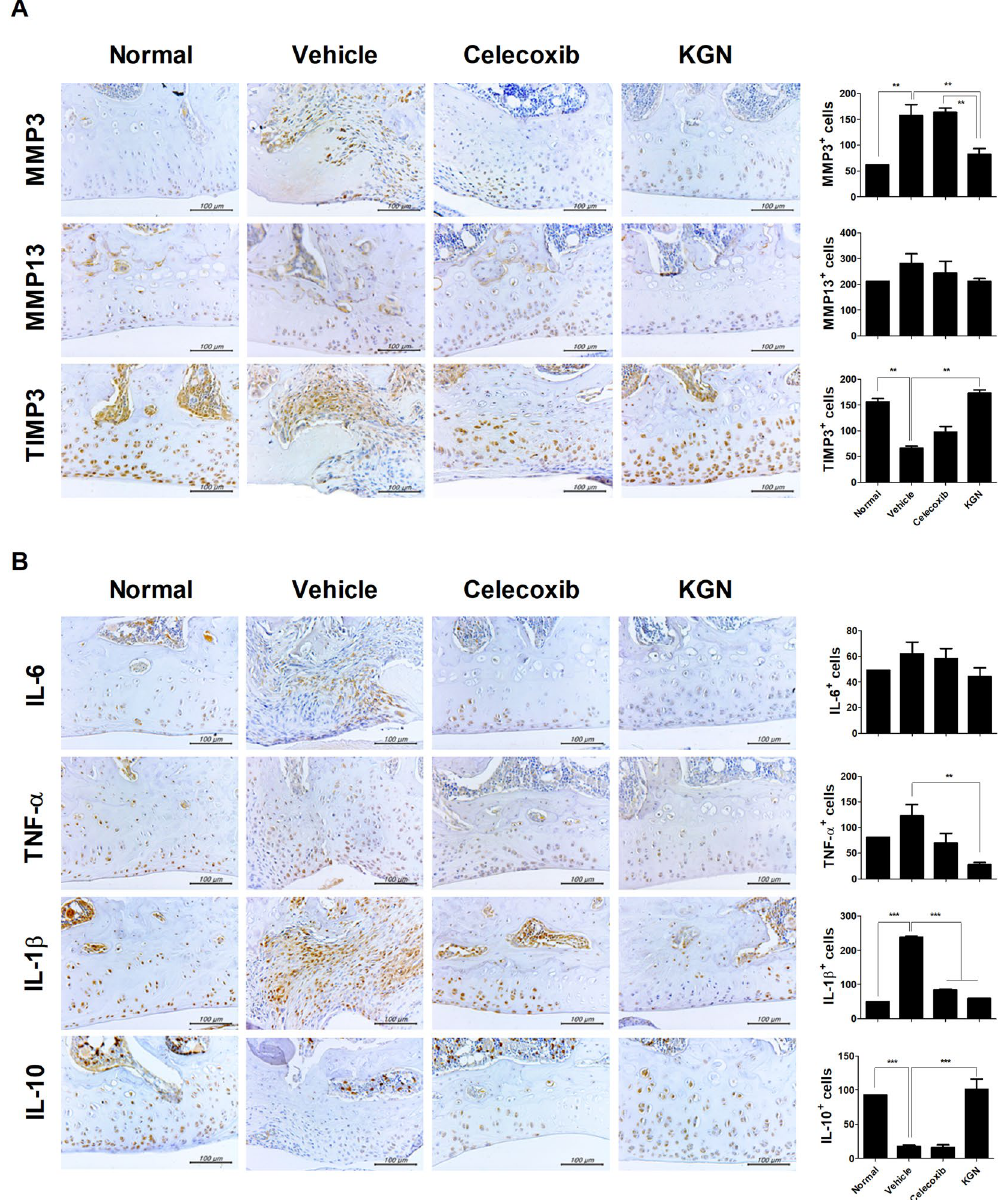
Figure 3. Histopathology of osteoarthritis of a cartilage and chondroclastic (osteoclastic) activity after treatment with KGN in the rat MIA model. ( A ) The level of MMP 3, -13 and TIMP3 were measured in cartilage. TIMP3 expression was increased by KGN. ( B ) The expression of cytokines such as interleukin-6, -1 β , TNF- α and IL-10 in cartilage is shown. Decreased expression of IL-6, IL-1 β , TNF- α and was induced by KGN and upregulation of IL-10 in cartilage of MIA-injected rats is shown. Tissue analysis was carried out two times in three animal models. These experiments were performed in 5 individual animal experiments. ** P < 0.001, *** P <